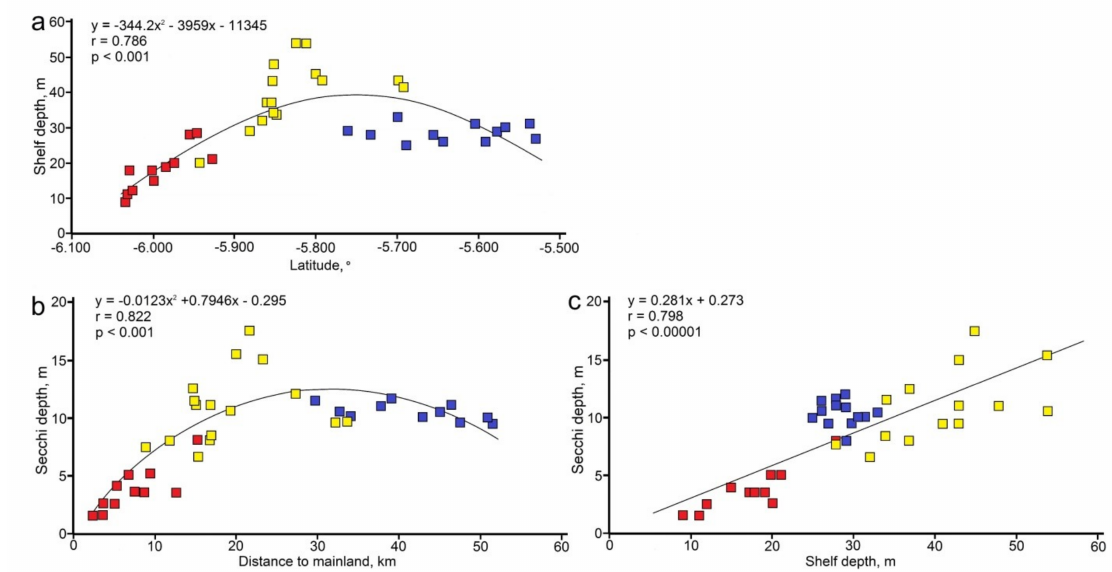
Figure 2. Significant relations between abiotic parameters off Jakarta: ( a ) Shelf depth in relation to latitude following quadratic model; ( b ) water transparency (secchi depth) in relation to distance from mainland, quadratic model; ( c ) secchi depth in relation to shelf depth, linear model. Color codes correspond with those of zones in Figure 1: Zone 1 (red), Zone 2 (yellow), Zone 3